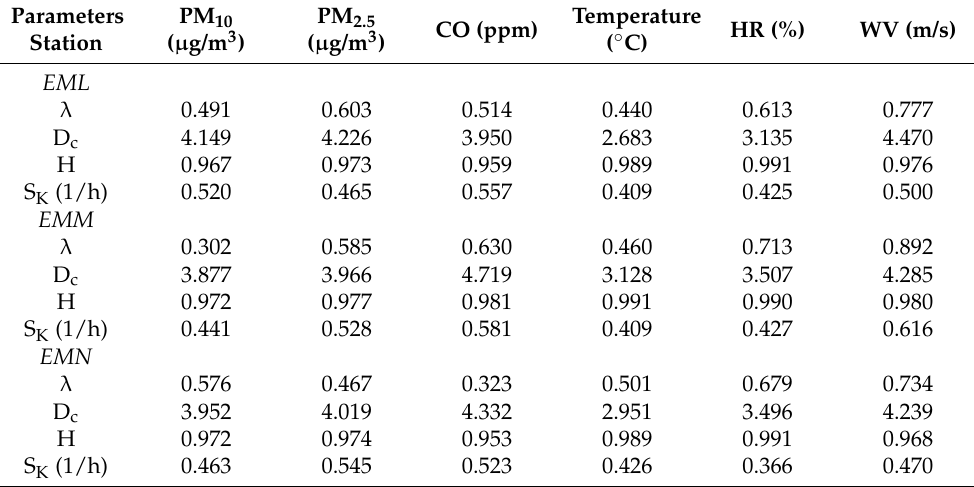
Table A1. Parameters for chaos study of three pollution variables and three meteorological ones, in six monitoring stations (Santiago, Chile, 2010–2013 Period)